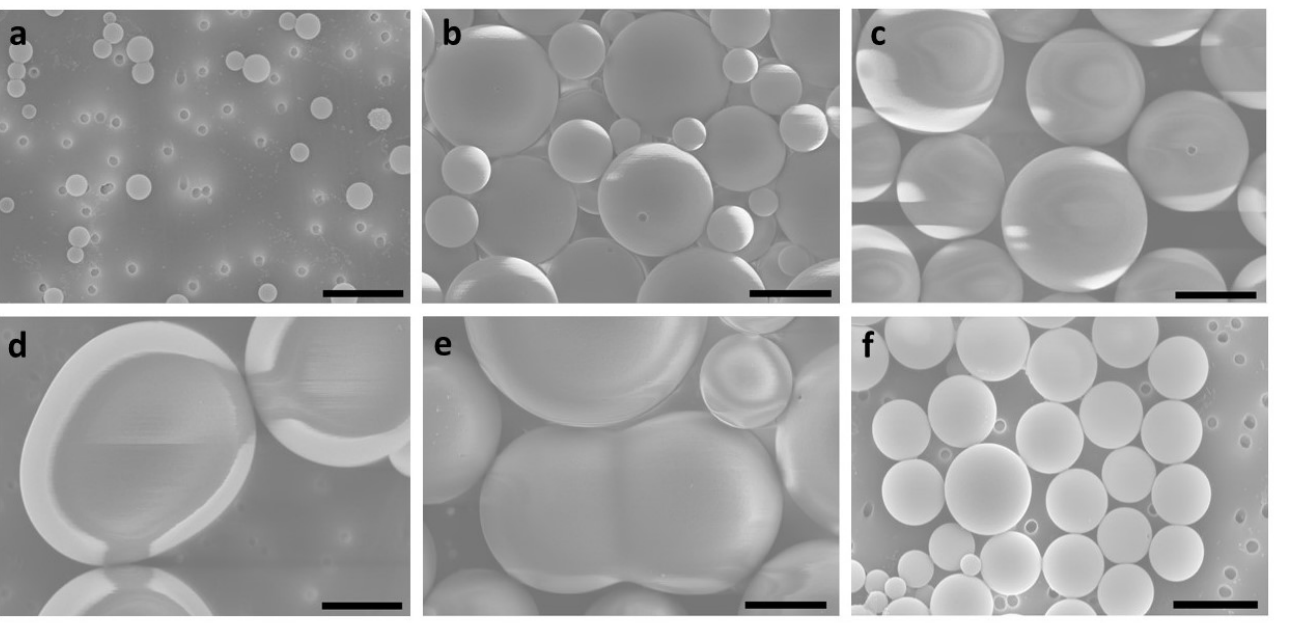
Figure 13. Exemplary SEM images to clarify the postulated ripening processes and behaviors of the PS-b-PAA vesicles in flow. ( a ) 400 rpm, 3 h, small vesicles; ( b ) 0 rpm, 24 h, large vesicles; ( c – e ) 100 rpm, 24 h, large vesicles (partially already deformed), as well as the incipient fission of vesicles; ( f ) 400 rpm, 24 h. Again, slightly smaller vesicles after the fission process. The scale bar is 1 µm.